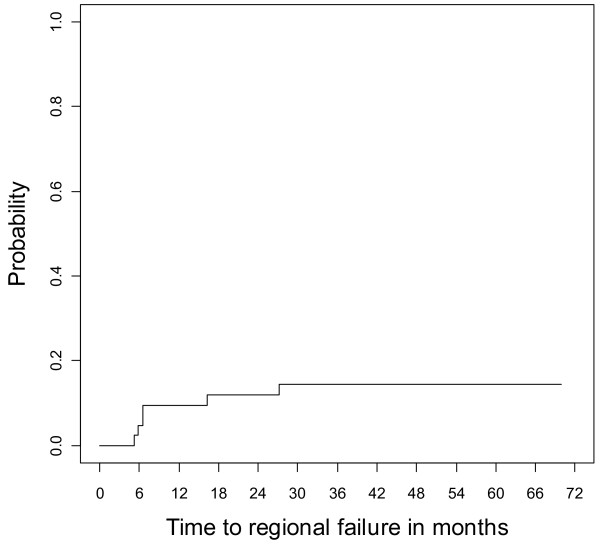
Cumulative incidence of regional recurrence.